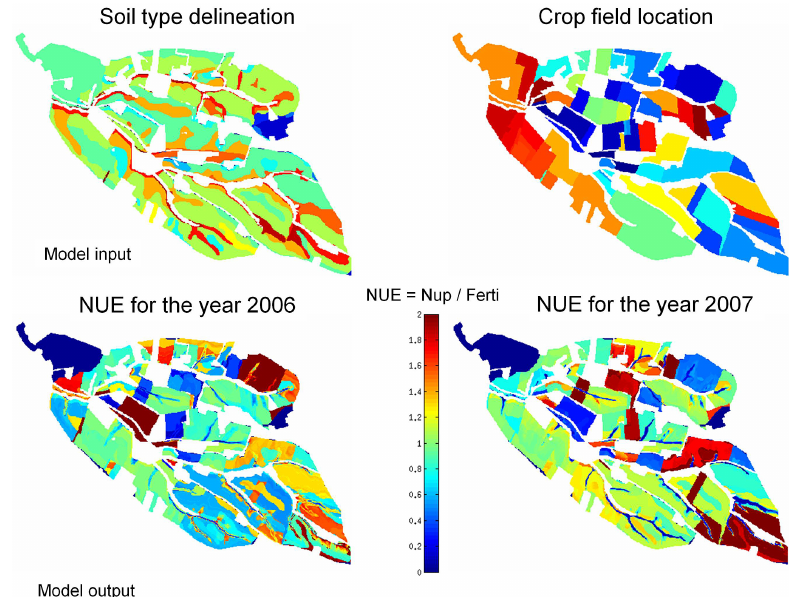
Figure 9. Soil and crop-field map used in TNT2 (top). Spatial NUEs for the years 2006 and 2007 (bottom left and right, respectively). The higher the value, the more efficiently the fertilizer is used by the plant. A low fertilizer amount with weak biomass production could lead to high NUE. Mineralization of soil organic matter creates a source of mineral nitrogen that leads to NUEs higher than